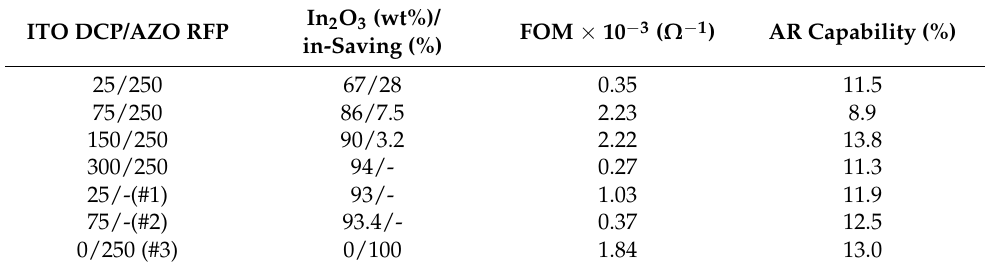
Table 6. FOM values and AR capability of the multicomponent materials developed, as function of the sputtering conditions used. The In 2 O 3 concentration and the amount of indium-saving are also